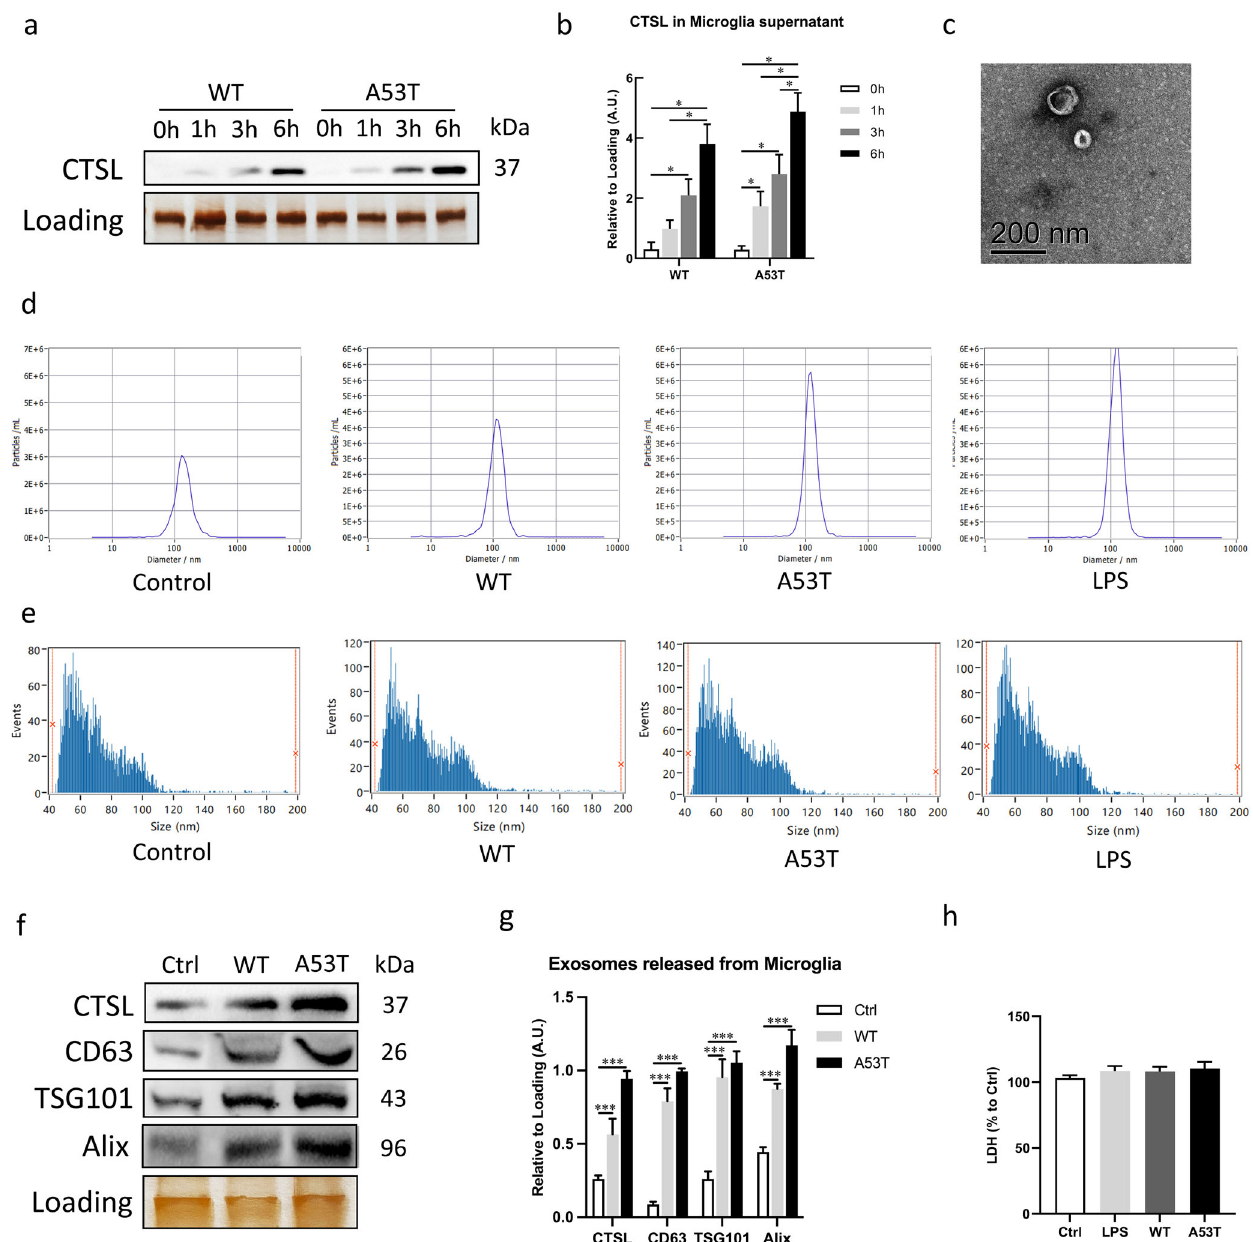
Fig. 1 Extracellular α -Syn oligomers promote microglial CTSL and exosome release, and exosomes carry CTSL in α -Syn-activated microglia in a time-dependent manner. a , b Western blot and quantitative analysis of CTSL release from microglia stimulated with extracellular WT or A53T α -Syn oligomer for up to 6 h ( n = 4); * p < 0.05. c Representative TEM images of exosomes isolated from the supernatant of primary microglia. Scale bar: 200 nm. d , e Analysis of the particle number and size of microglia-derived exosomes from the different treatment groups by NTA and a Flow Nano Analyser ( n = 4). f , g The results of Western blot analysis showing the presence of the exosomal markers CD63, TSG101 and Alix, and a high level of CTSL in exosomes from WT and A53T α -Syn oligomer-activated microglia ( n = 4); *** p < 0.001. h LDH levels in the microglial culture medium were measured by ELISA after different treatments ( n = 6). Ctrl = untreated control. Error bars represent BzATP treatment (Fig. 3c, d) and that the secretion of CTSL Fig. 2d, neither WT α -Syn monomer nor A53T α -Syn monomer occurred mainly through exosomes (Fig. 3e, f). Moreover, interacted with P2X7R. These observations suggest that α -Syn incubation with Brilliant Blue G (BBG), a P2X7R antagonist, oligomers may induce CTSL-containing exosome release by 10 min before α -Syn oligomers treatment signi fi cantly reduced interacting with P2X7R. To test this hypothesis, we fi rst treated the secretion of CTSL via exosomes in both the WT and A53T α - microglia with 100 mM 2 ’ (3 ’ )-O-(4-benzoylbenzoyl) adenosine 5 ’ - Syn oligomers-treated groups (Fig. 3e, f), implying the involve- triphosphate (BzATP), a P2X7R agonist that is 10-fold more potent ment of P2X7R activation in this process. Similar results were than ATP 37 , with 250 nM BSA being used as a negative control obtained when P2X7R was knocked down in microglia before Supplementary Fig. 2c). Our results showed that the highest level treatment with α -Syn oligomers (Fig. 3g, h). These investigations of CTSL release from microglia occurred approximately 6 h after